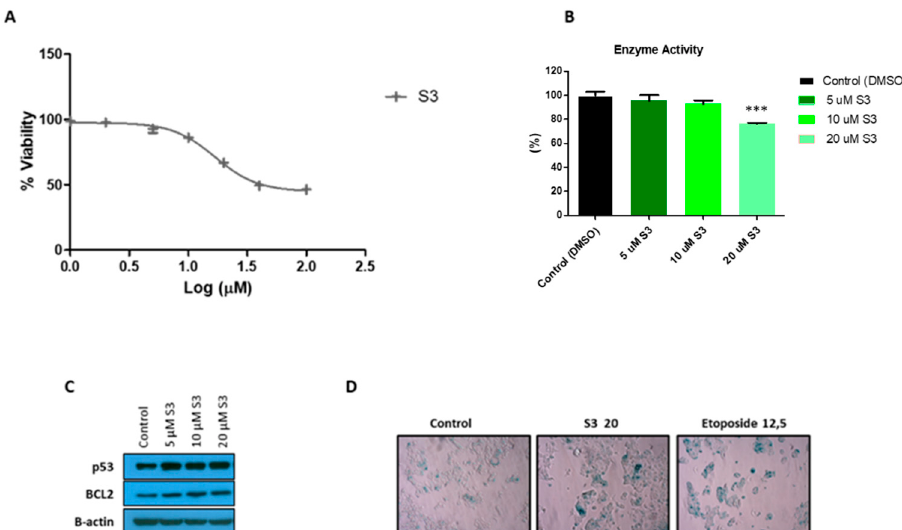
Figure 5. ( A ) Dose response curve of MCF7 cells for selective 6PGD inhibitor S3 after 72 h of treatment of cells with different doses of S3. ( B ) Relative 6PGD specific enzyme activity levels 24 h post treatment with S3. Fold change was quantified relative to control. ( C ) Western blot analysis of p53 and BCL2 expression in cells treated with different doses of S3 or control for 72 h. ( D ) Representative photographs showing increased SA- β -gal positive cells in MCF7 cells treated with 20 µ M of S3 compared to cells treated with DMSO alone. In addition, 12.5 µ M etoposide was used as a positive control as it is known to induce senescence. Three asterisks (***) denote p -value < 0.001.